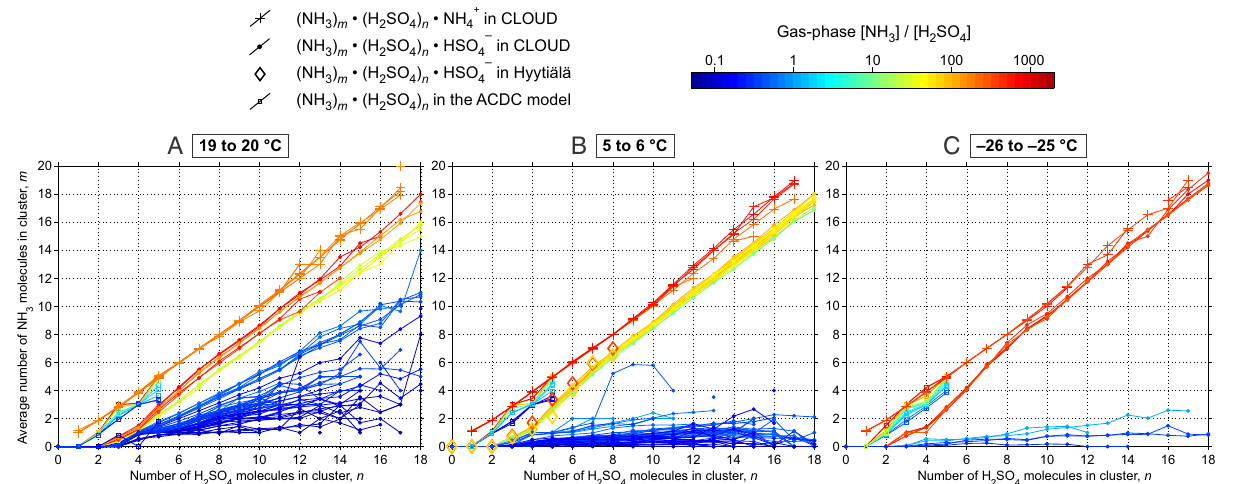
Figure 4. The average number of NH 3 molecules ( m) in clusters with a certain amount of H 2 SO 4 molecules ( n) , for negatively charged clusters (NH 3 ) m · (H 2 SO 4 ) n · HSO − (CLOUD experiments, Hyytiälä), positively charged clusters (NH 3 ) m · (H 2 SO 4 ) n · NH + 4 periments) and neutral clusters (NH 3 ) m · (H 2 SO 4 ) n (ACDC model). Experiments are grouped by temperature into panels (a) (19 to 20 ◦ C), (b) (5 to 6 ◦ C), (c) ( − 26 to − 25 ◦ C); mean relative humidities were 21% to 84% (anions, CLOUD), 20% to 40% (cations, CLOUD), 41% and 58% (anions, Hyytiälä). The resulting curves are near linear from about n = 4 (anions) or n = 1 (cations, neutrals) onwards. The principal factor determining the slopes is the ratio of gas-phase concentrations [NH 3 ]/[H 2 SO 4 ] (color